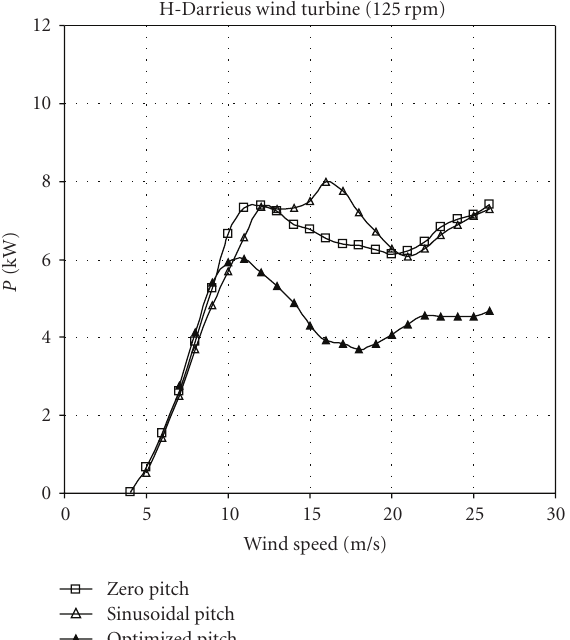
Figure 7: Power versus wind speed for the 7kW VAWT with fixed and optimized variable pitch.